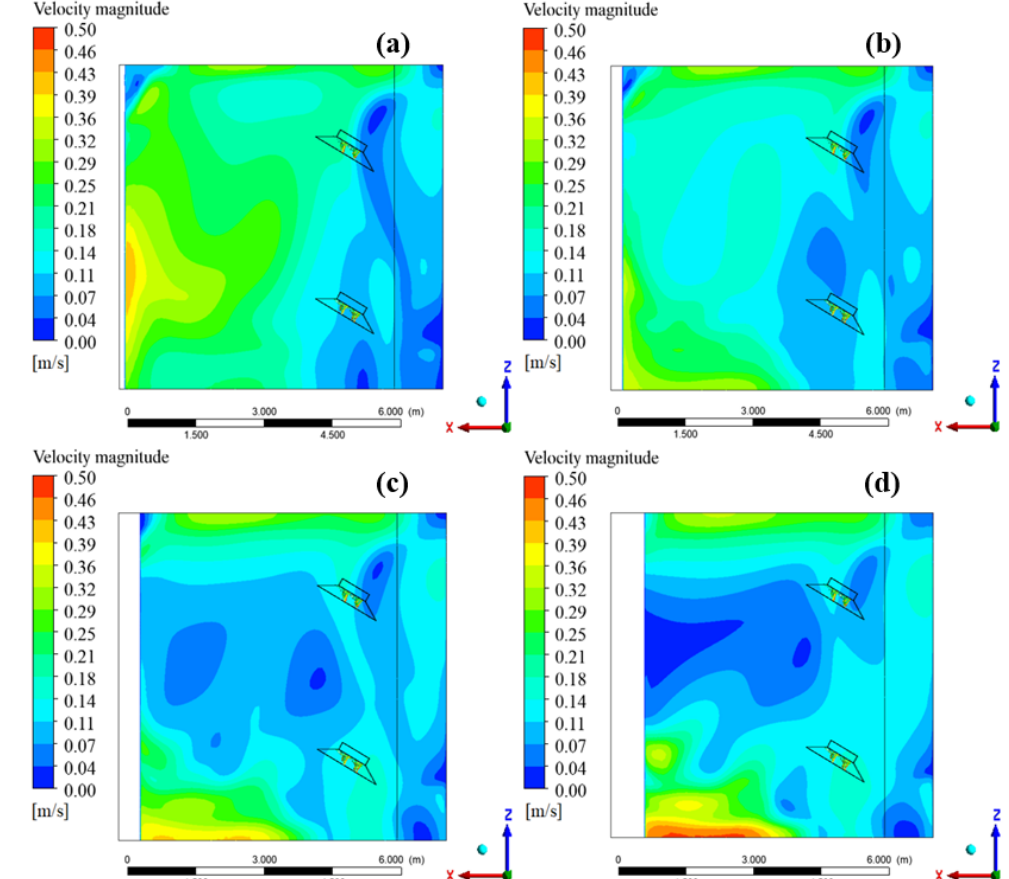
Figure 19. Velocity distribution contours for four horizontal profiles when the side opening angle was 60°: plane 1 — 0.7 m ( a ), plane 2 — 1.0 m ( b ), plane 3 — 1.3 m ( c ), and plane 4 — 1.6 m ( d ).